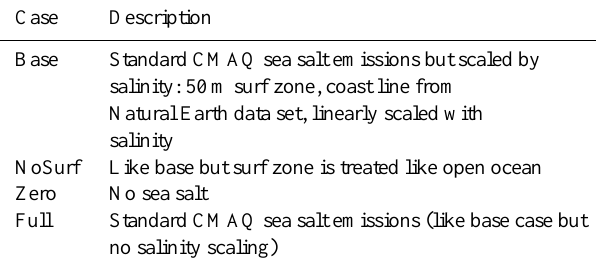
Table 1. Sea salt emission cases.